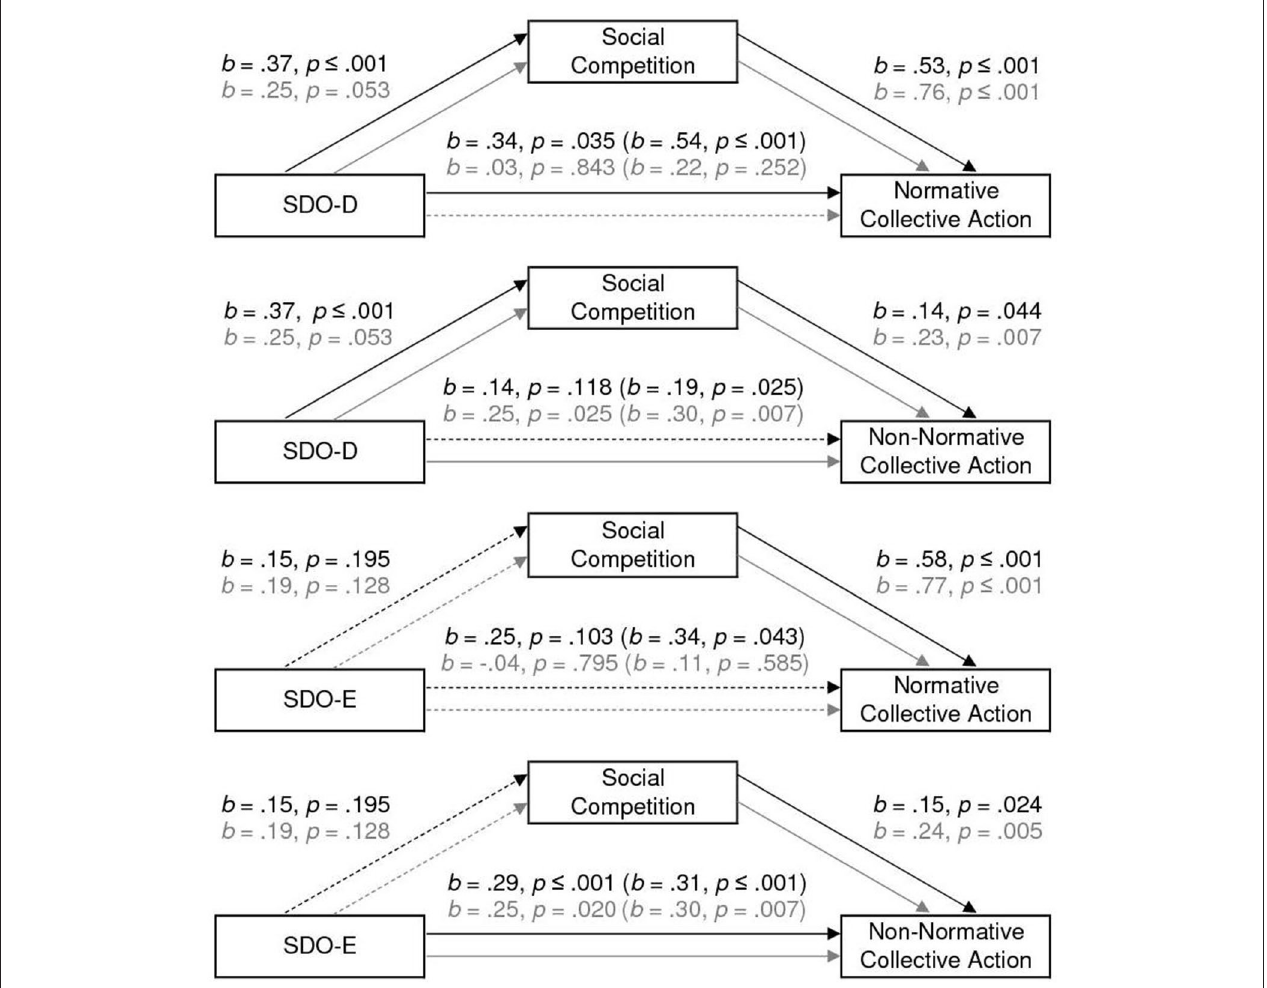
FIGURE 2 | The effect of SDO on normative CA and non-normative CA, mediated by social competition. Coefficients for the SLB supporters (high-status group) are in gray. All reported coefficients are